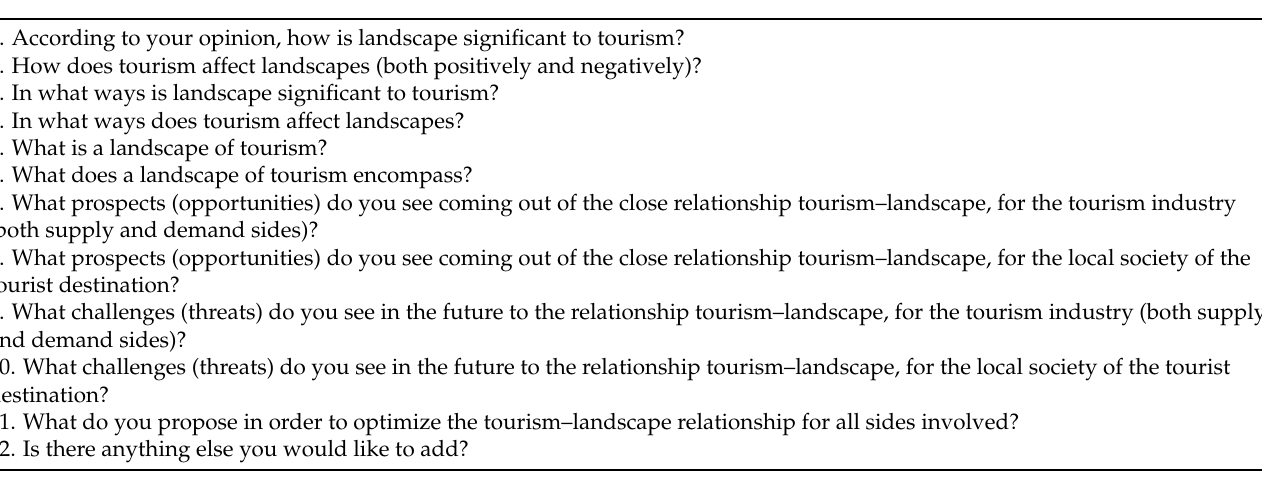
Table 1. The online survey questionnaire.